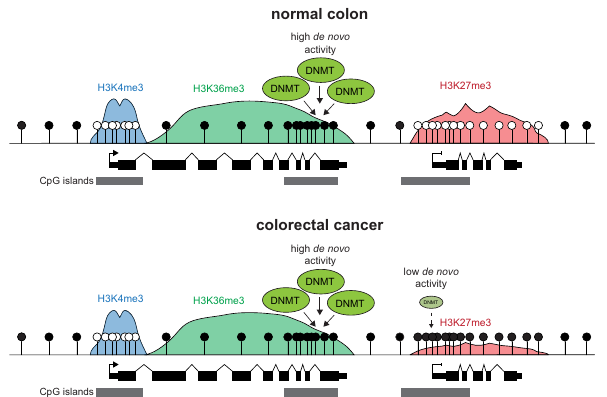
Fig. 6 De novo DNA methyltransferase activity in colorectal cancer is directed towards H3K36me3 marked CpG islands. Graphical model of the distribution of de novo DNMT activity at CGIs in colorectal cancer. Our data support a model whereby the CGIs subject to the highest levels of de novo DNMT activity in both the normal and cancerous colon are those marked by H3K36me3. Although CGIs marked by H3K27me3 in the normal colon become aberrantly methylated in colorectal cancer 4 – 6 , our results suggest that this is associated with inef fi cient de novo methylation. H3K27me3 is lost from these CGIs when they become aberrantly methylated 83